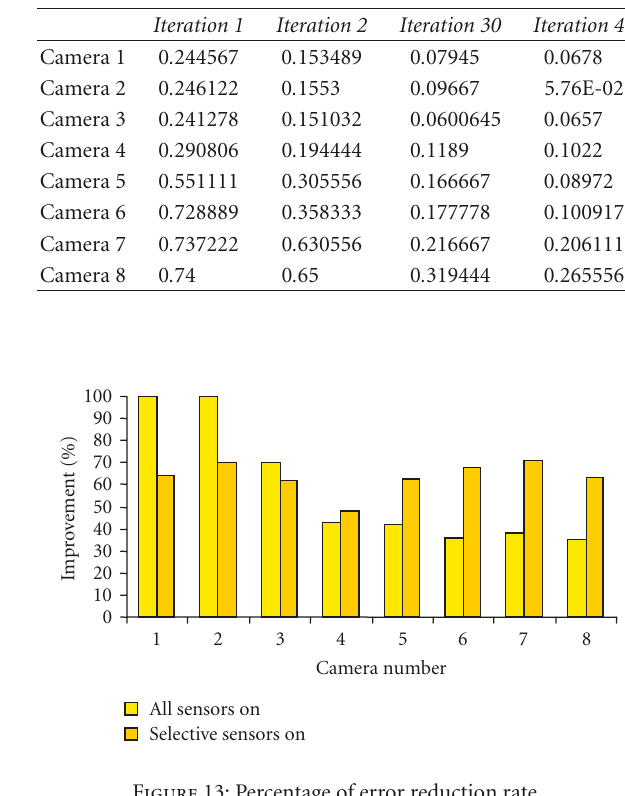
Figure 13: Percentage of error reduction